Question: State the chart type depicted above.
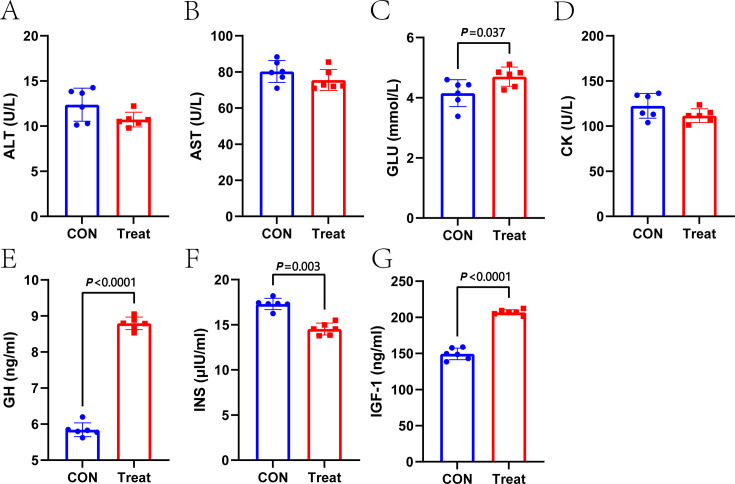
Answer: bar